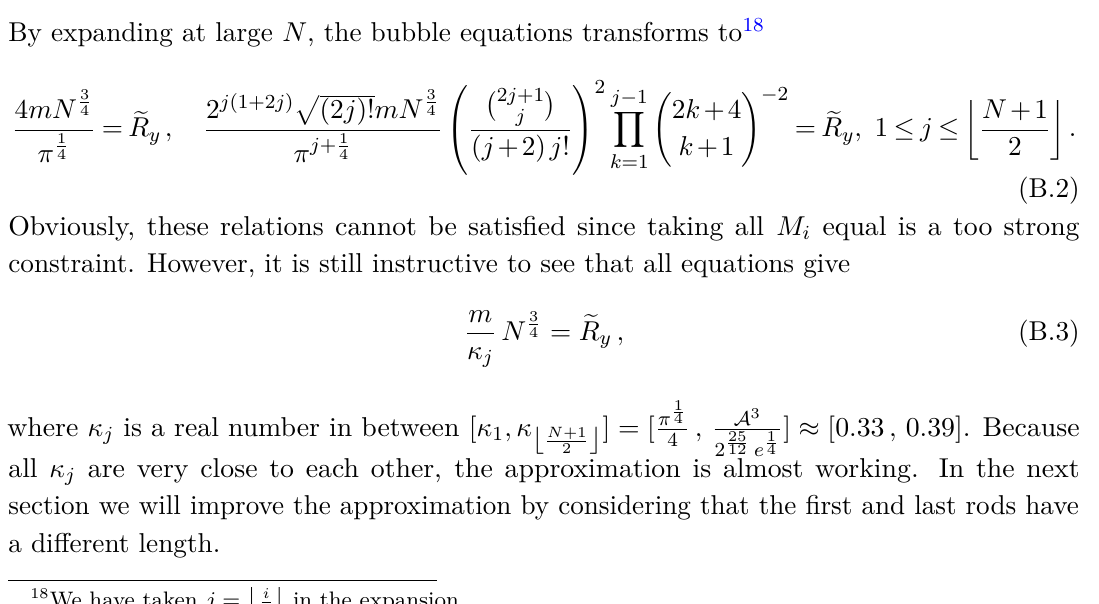
Figure 12. Plots of the rod lengths M i as a function of the rod label, i , for different rod configurations. The top plot gives the lengths of the odd rods, M bubbles, starting with a configuration of 9 bubbles up to a configuration of 99 bubbles. The bottom plot shows the lengths of the even and odd rods for the configuration of 99